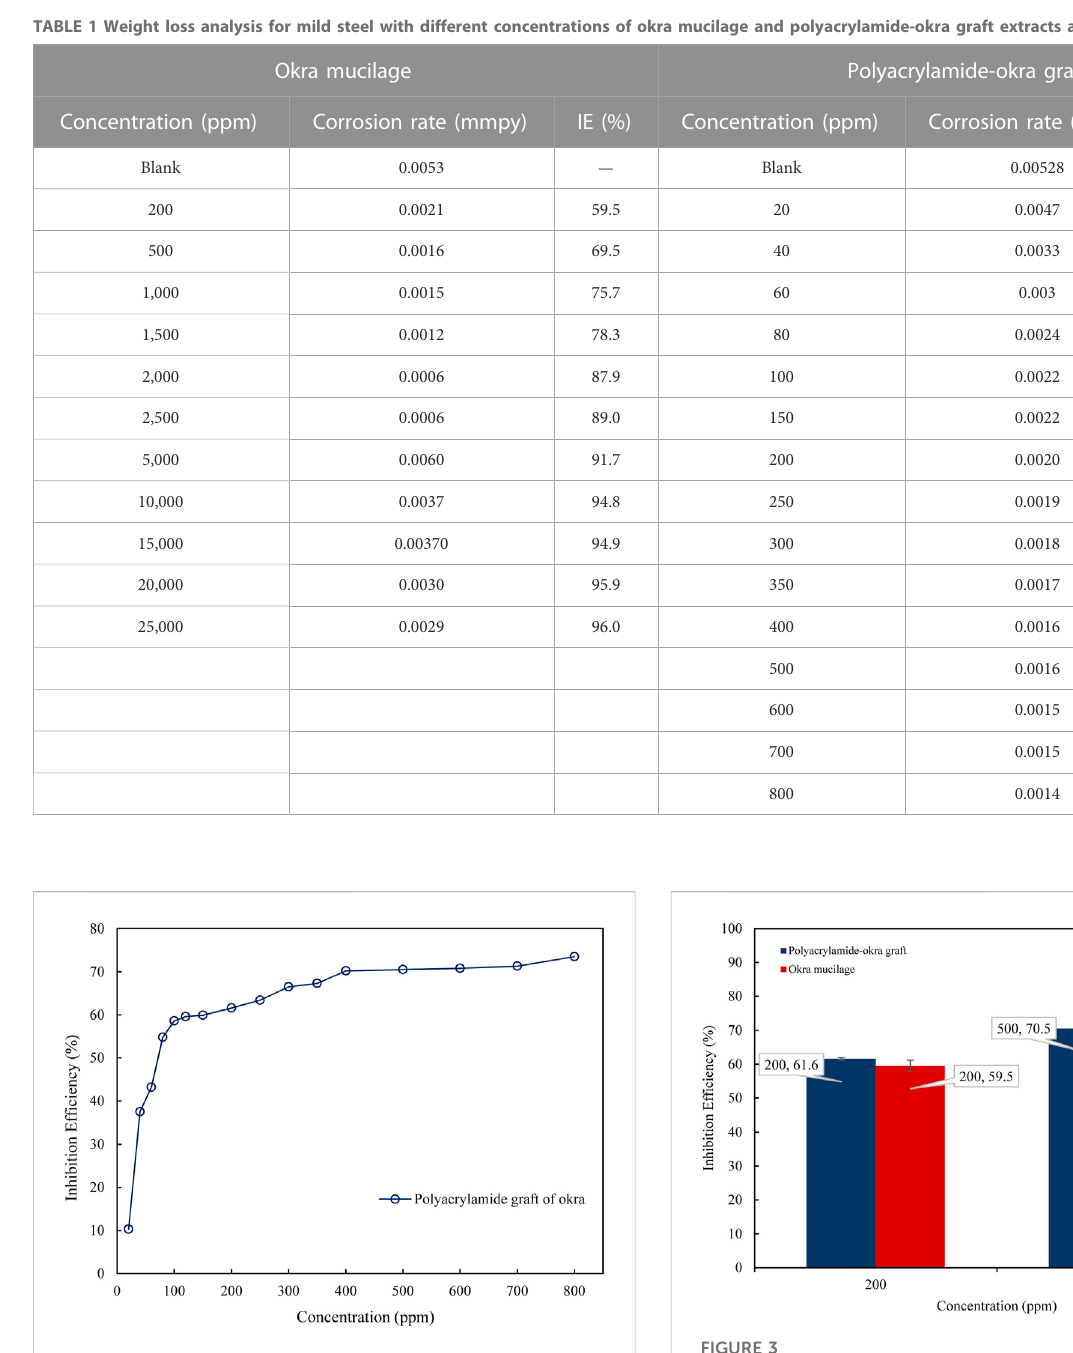
FIGURE 2 Inhibition performance of polyacrylamide graft of okra.